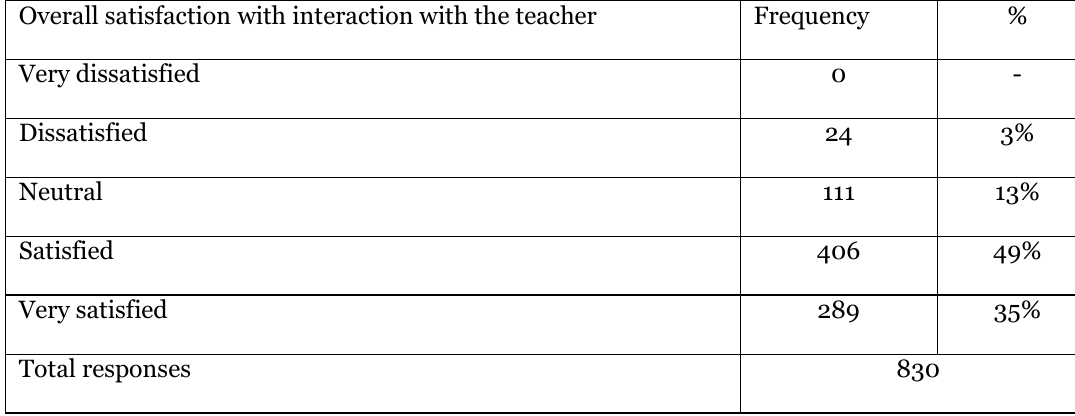
Percentages of Students’ Responses Concerning Interaction With the Teacher Overall satisfaction with interaction with the teacher Frequency % Very dissatisfied 0 - Dissatisfied 24 3% Neutral 111 13% Satisfied 406 49% Very satisfied 289 35% Total responses